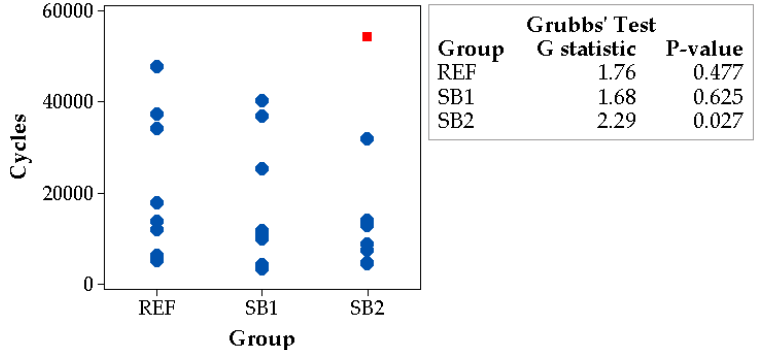
Figure 7. Outlier analysis of the three groups of asphalt mixtures using the Grubbs test.